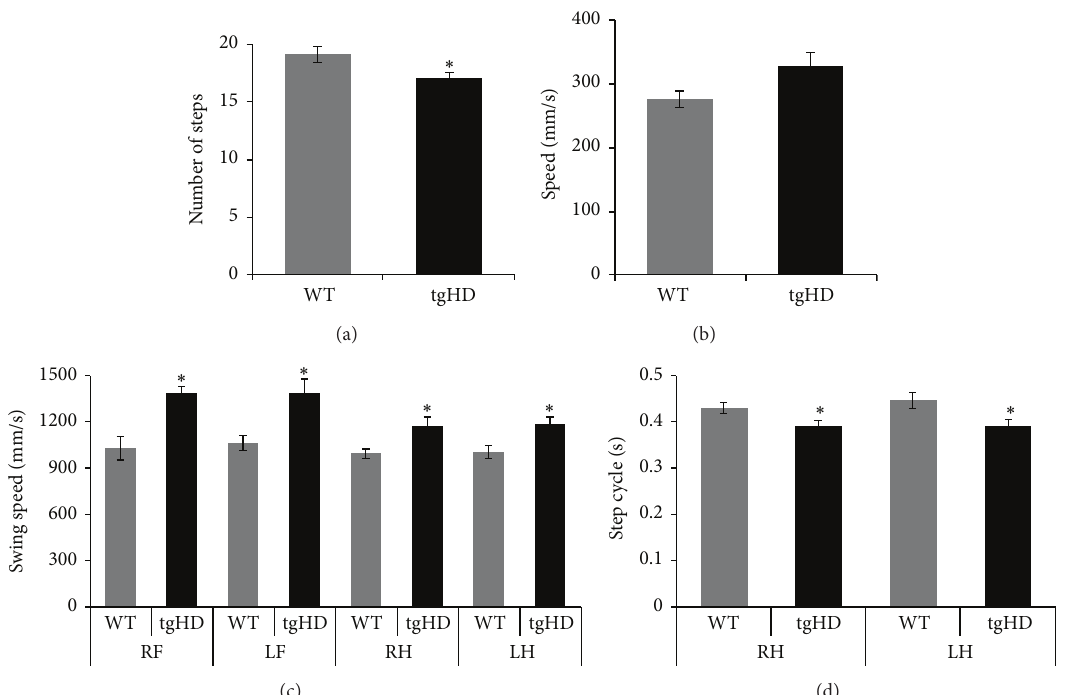
Figure 3: Dynamic gait parameters—(a) the graph shows the average number of steps, comparing transgenic (tgHD) with wild-type (WT) rats. (b) The graph represents the average speed in mm/s of the 9-month-old tgHD versus WT rats. (c) The graph shows the swing speed belongs to 4 paws of tgHD compared with WT rats. (d) The graph shows the step cycles in seconds for the hind paws from the tgHD compared with WT rats. RF: right front paw; LF: left front paw; RH: right hind paw; LH: left hind paw. The values are presented as mean ± standard error of the mean (SEM) and statistically significant difference ( 𝑃 < 0.05 ) is indicated by an ( ∗ ).